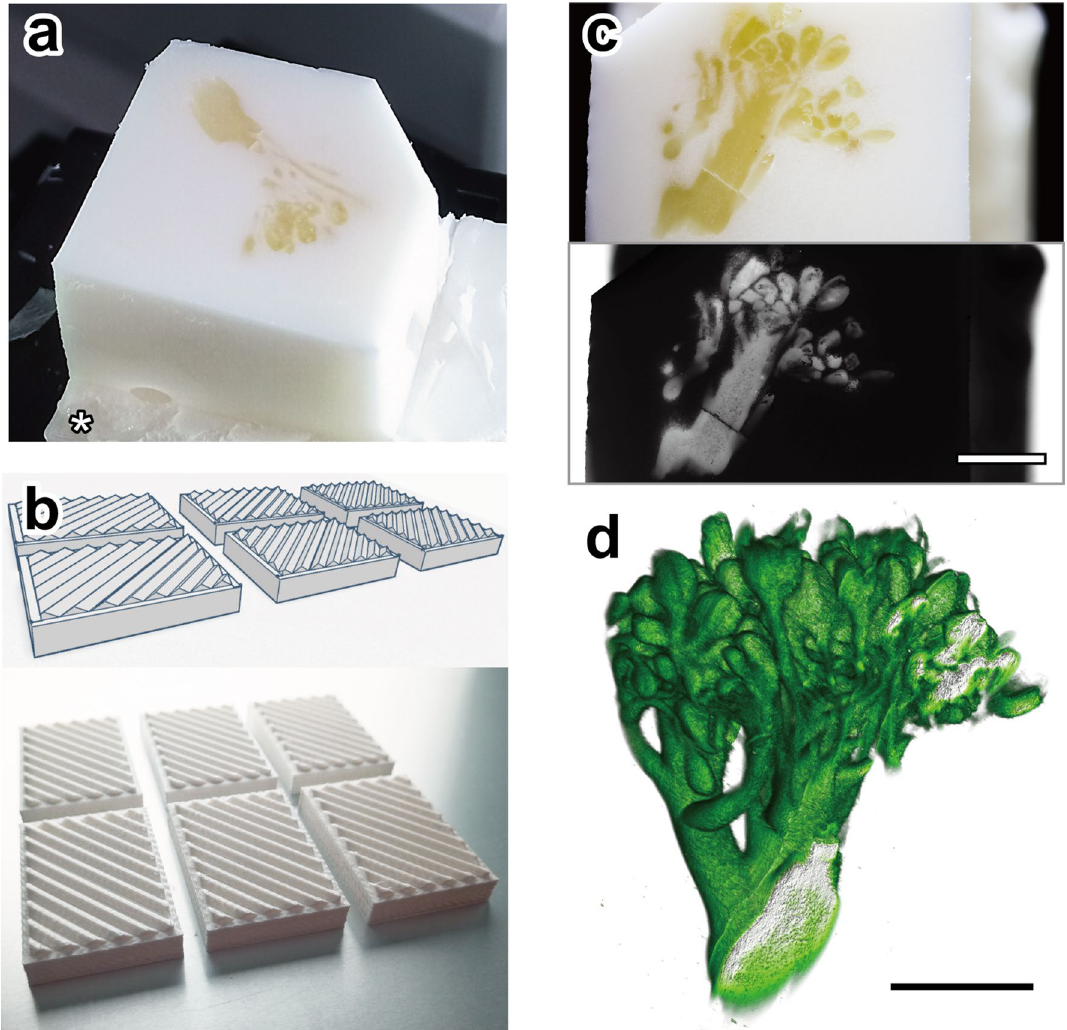
Figure 4. Opacification of paraffin block using white crayon. ( s ) A piece of broccoli was embedded in paraffin containing 6.25% w/w white crayon and placed on the custom-made attachment (asterisk). ( b ) The custom- made white attachment was designed (upper image) and made using 3D printing machine (lower image). Characteristics of the attachment are the white color and the sawtooth pattern on the top, which avoid shadows and increase the area for attaching paraffin block. ( c ) The border between broccoli specimen and white paraffin is apparent on the block face (upper image). When the block-face image was converted to grayscale image for volume rendering, only the cutting face of the broccoli specimen is seen (lower image). ( d ) The serial block- face images (270 images with a voxel size of 20 × 20 × 20 µm) were converted to grayscale images ( c ), then used for volume rendering ( d ). Bars: 5 mm. The STL file of attachments is available at GitHub (https:// github. com/ combi- 3d/ CoMBI- Slidi ng- micro Opacification of paraffin block using “crayon method” and custom white attachment. Another opacification method is adding crayon directly to paraffin. Broccoli was embedded in paraffin containing 6.25% w/w white crayon and imaged using CoMBI-S (Fig. 4a). As the slicing and imaging progressed, the block face got closer to the plastic attachment at the bottom, and there was a concern that the color and pattern of the attachment would be seen through. To eliminate such concern, a custom-made attachment was made with a 3D printing machine (Fig. 4b). The characteristics of the attachment are the white color and a sawtooth pattern on the top surface. Such pattern increases the surface area for better attachment to the paraffin block and does not create shadows during imaging since it is aligned parallel with the direction of illumination of the CoMBI-S system. Using a combination of white crayons and custom-made white attachments, we ensured that the area around the specimen can be imaged in white through the block-face imaging process (Fig. 4c). The block face presented only the cutting face of the broccoli, indicating successful opacification. Serial block-face images were converted to grayscale images and then successfully used for volume rendering (Fig. 4d). We prefer to use the crayon method for relatively larger specimens, as shown in Fig. 4. If a small sample, such as the juvenile zebrafish in Fig. 2, is embedded in white crayon-paraffin, it will be difficult to see and locate.